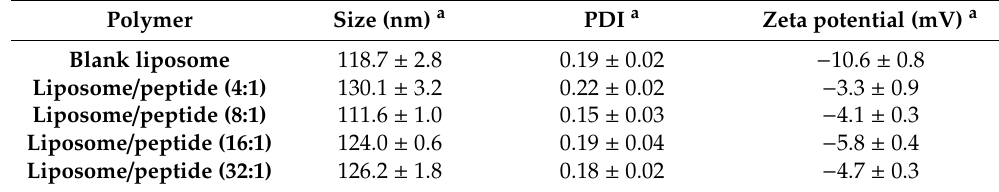
Table 1. Characterization of peptide complexed liposomes.